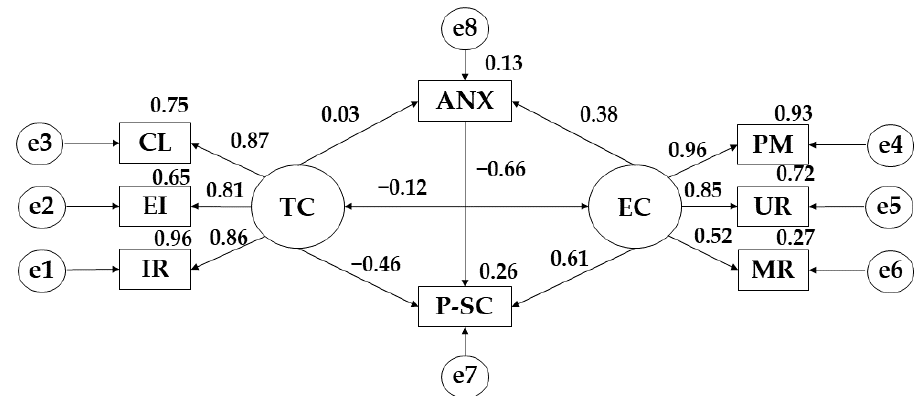
Figure 4. Model developed for high adherence to the Mediterranean diet. Note: Task Climate (TC); Cooperative Learning (CL); Effort/Improvement (EI); Important Role (IR); Ego Climate (EC); Punishment for Mistakes (PM); Unequal Recognition (UR); Member Rivalry (MR); Physical Self-Concept (P-SC); Anxiety (ANX).